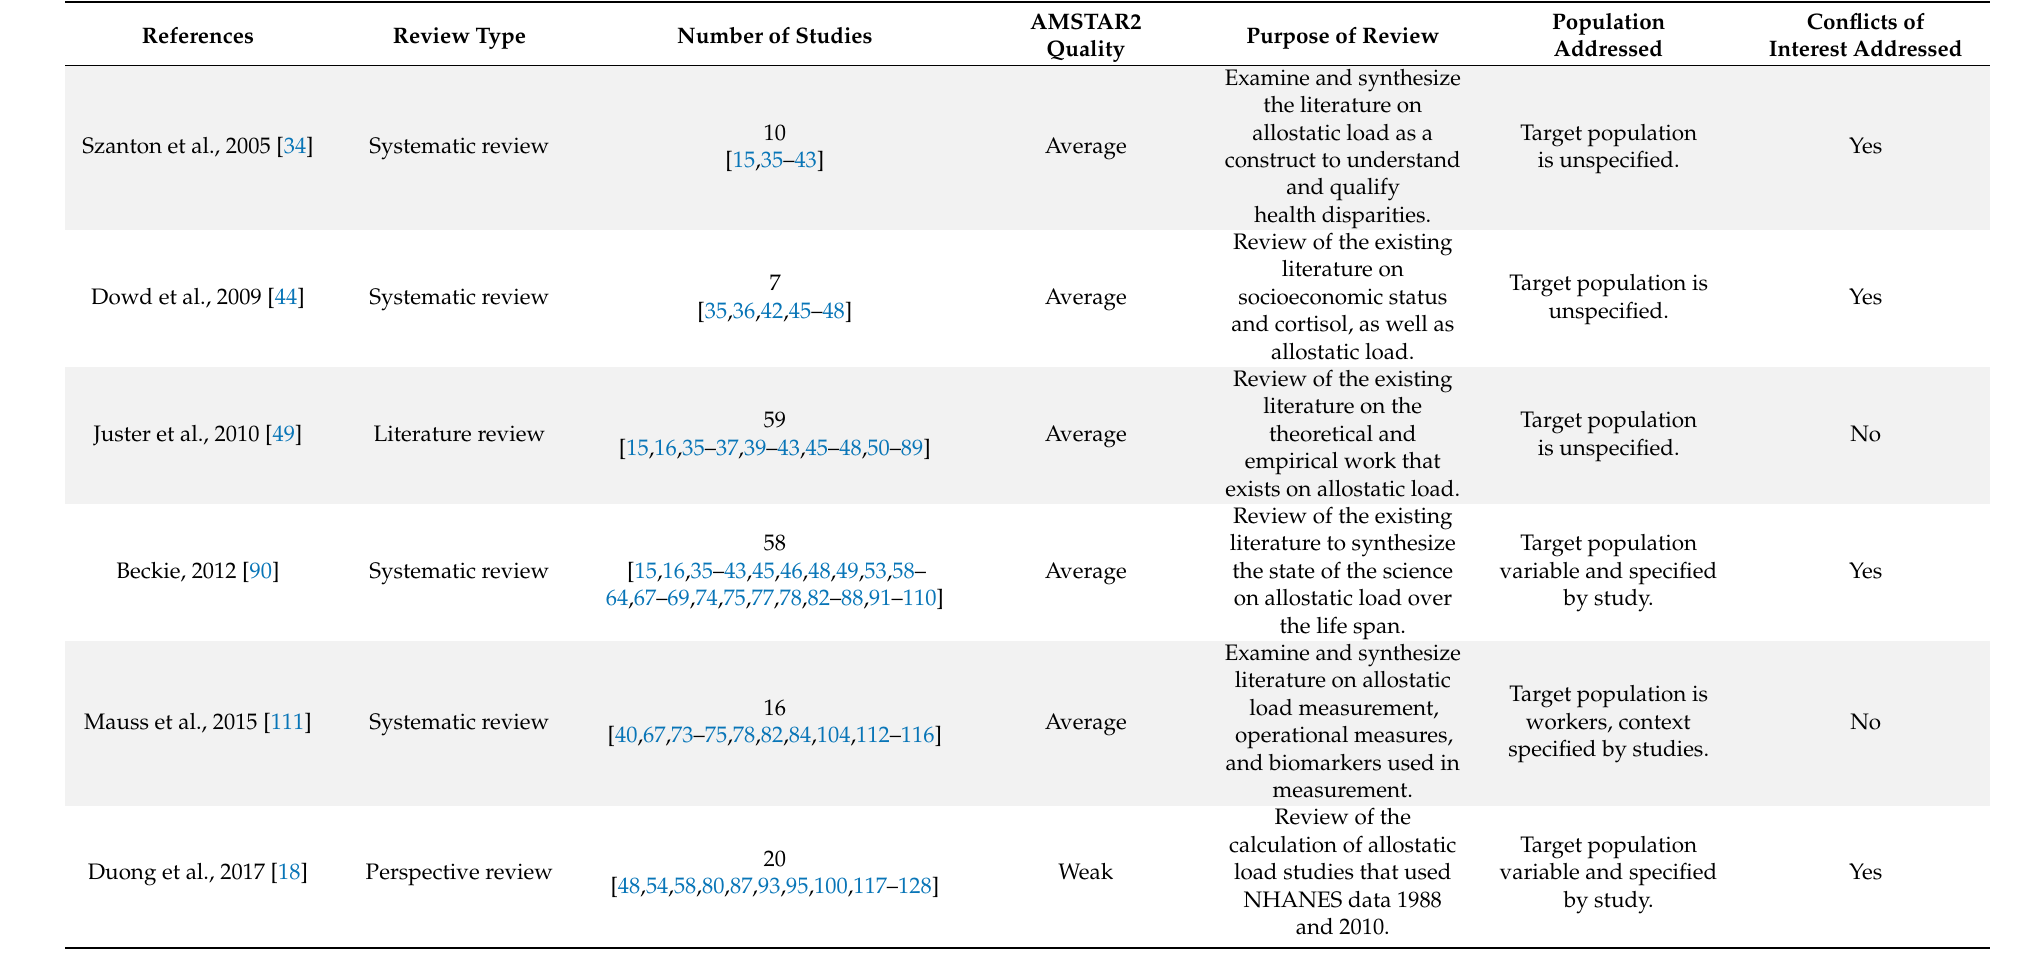
Table 1. Characteristics of the analyzed articles extracted from 18 synthesis article reviews identified through a systematic literature search for “allostatic load” conducted on 6 July